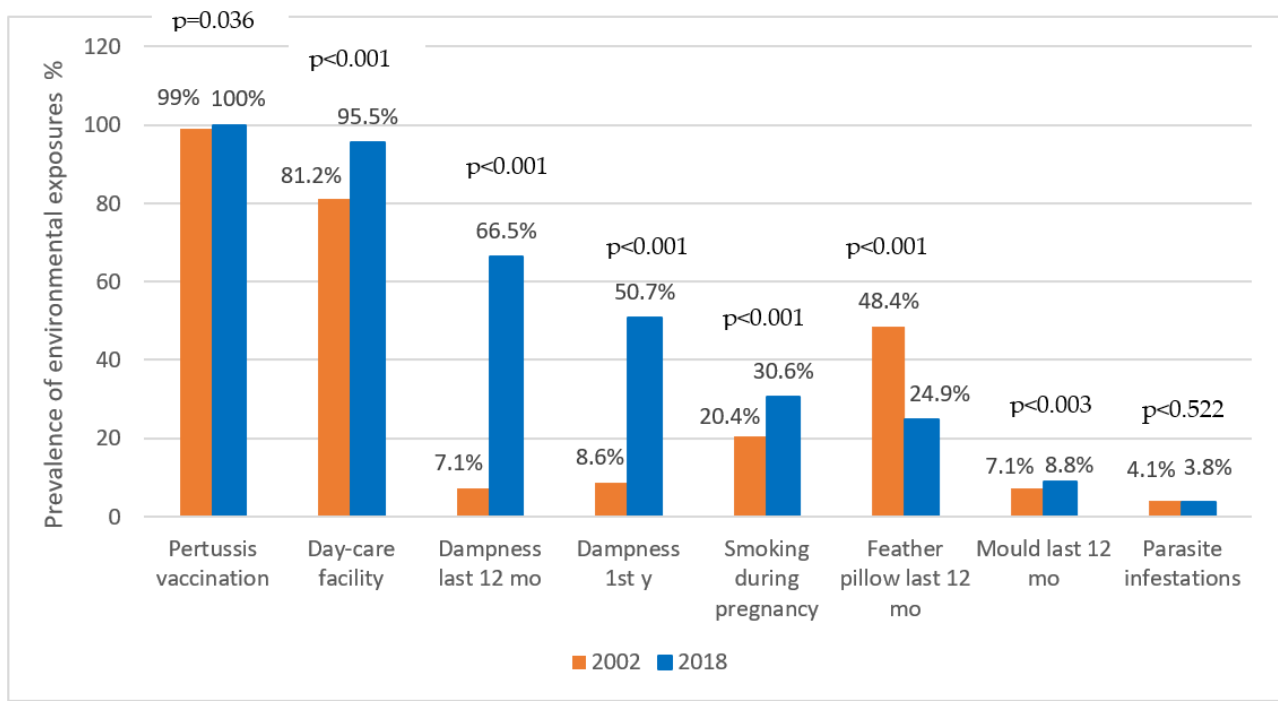
Figure 6. Changes in single-environmental exposures, 2002 – 2018.